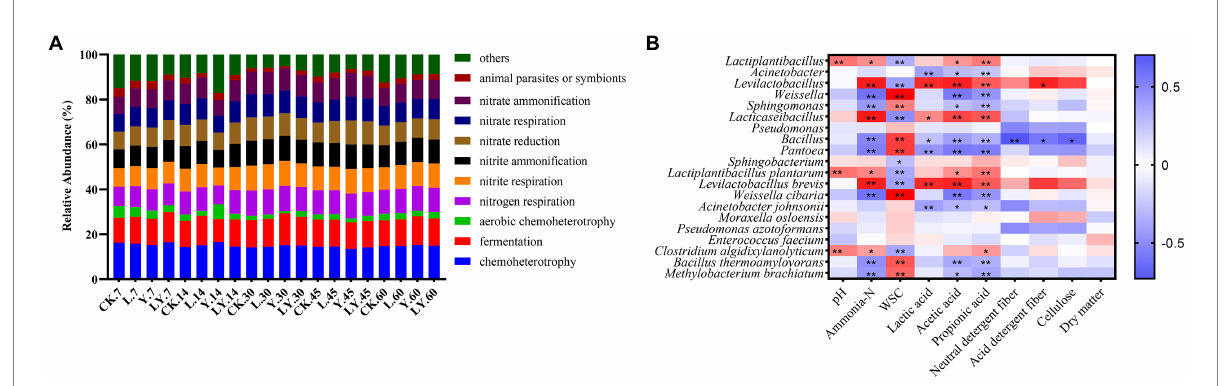
FIGURE. 2 The functional prediction of bacteria (A) in cellulase-treated Pennisetum sinese (CTPS) during anaerobic storage and Spearman correlations between the fermentation parameters and the relative abundance of top 10 bacterial genera and species (B) . CK, control; L, Lentilactobacillus buchneri ; Y, yeast; LY, a mixture of L. buchneri and yeast; WSC, water-soluble carbohydrates.